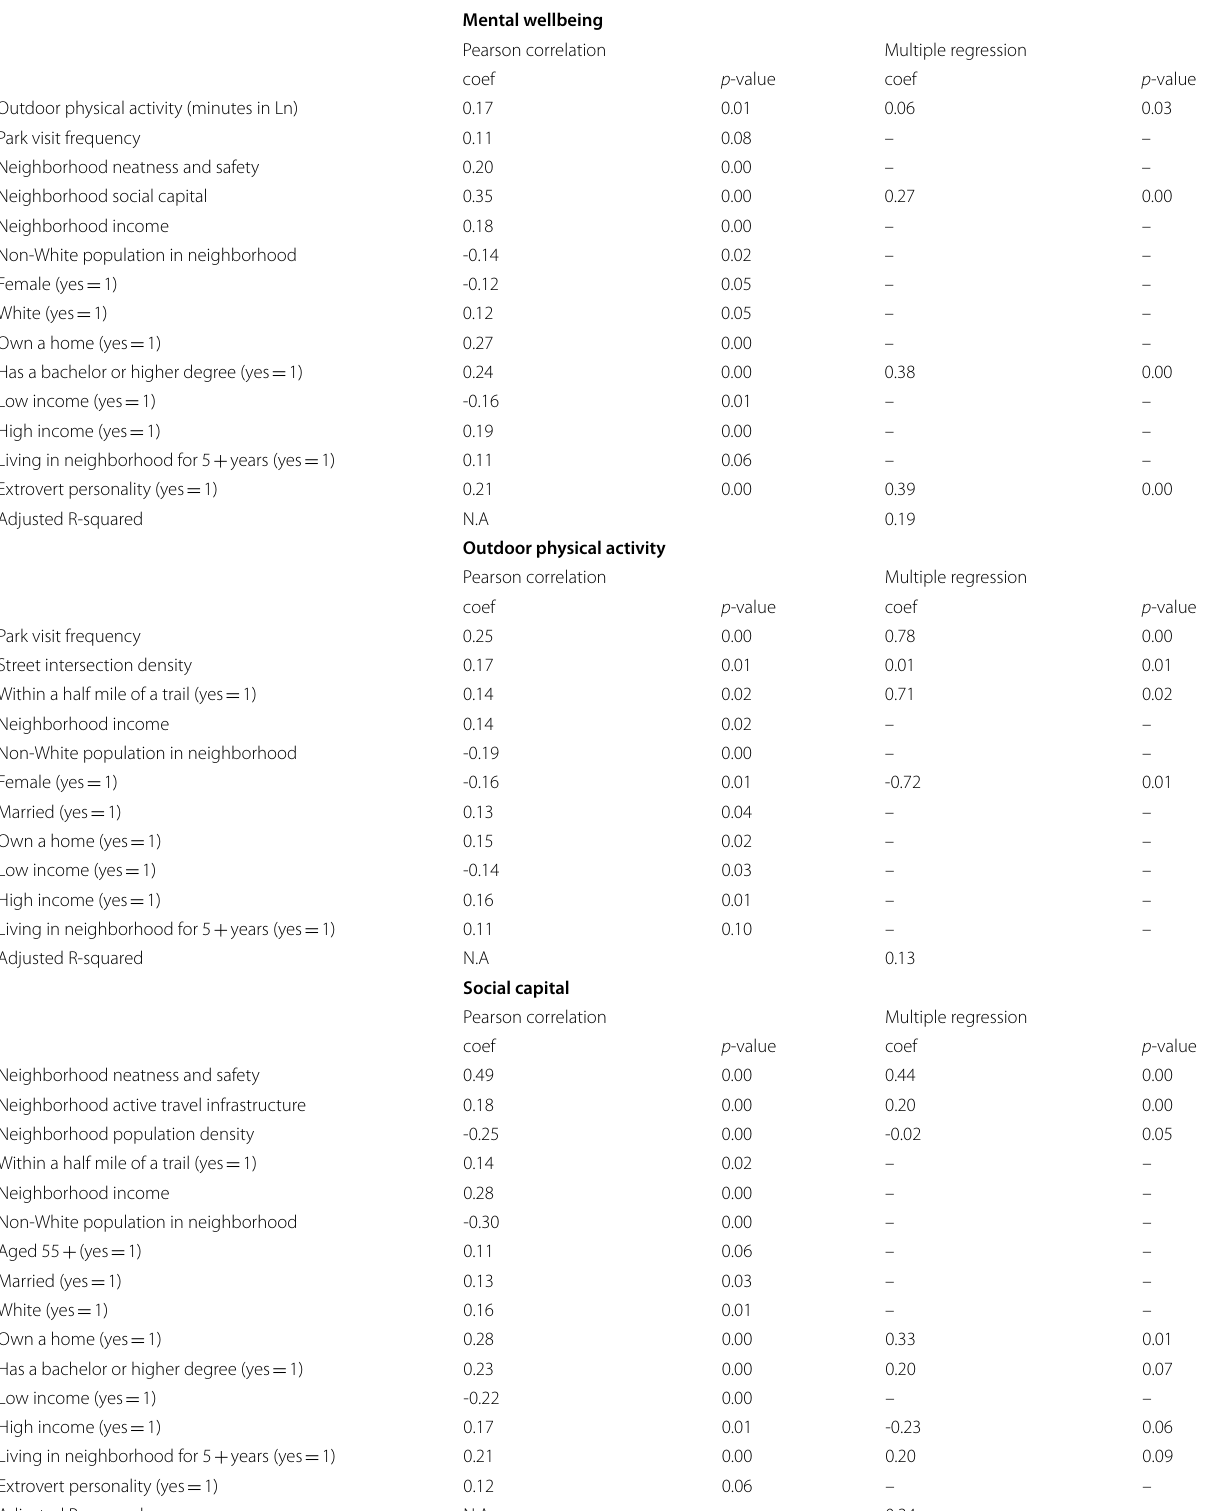
Table 2 Predictors of mental wellbeing, physical activity, and social capital